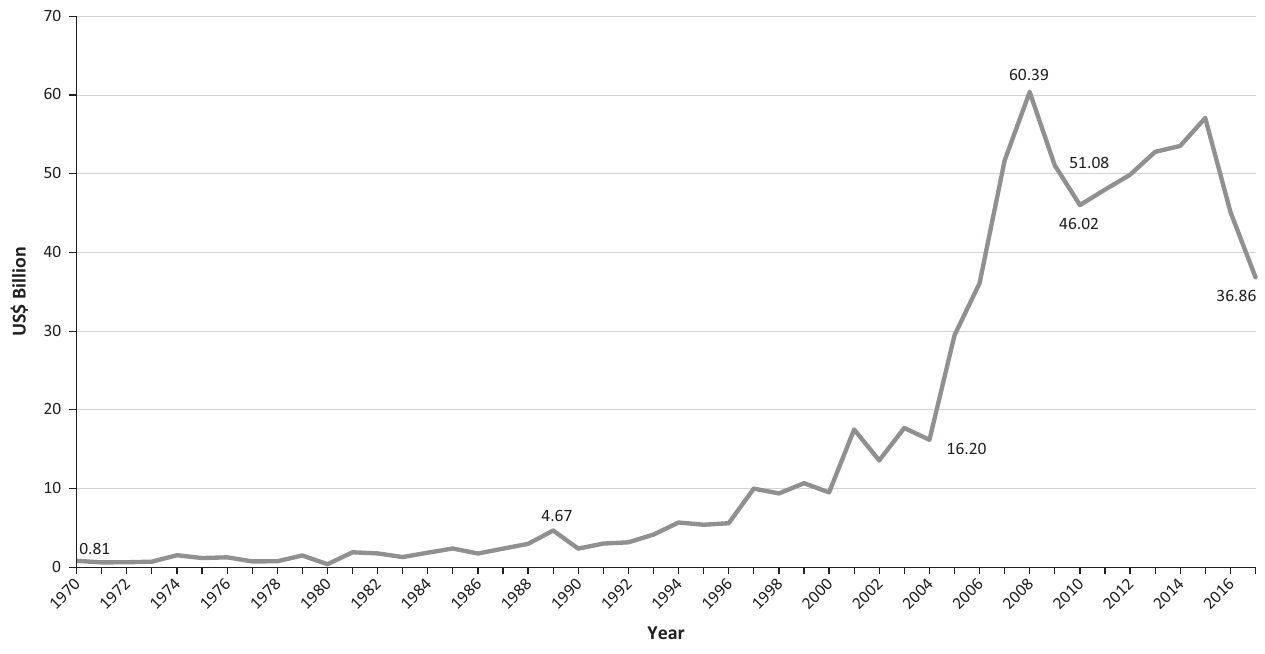
FIGURE 2: Net inflows of foreign direct investment in continental Africa from 1970 to